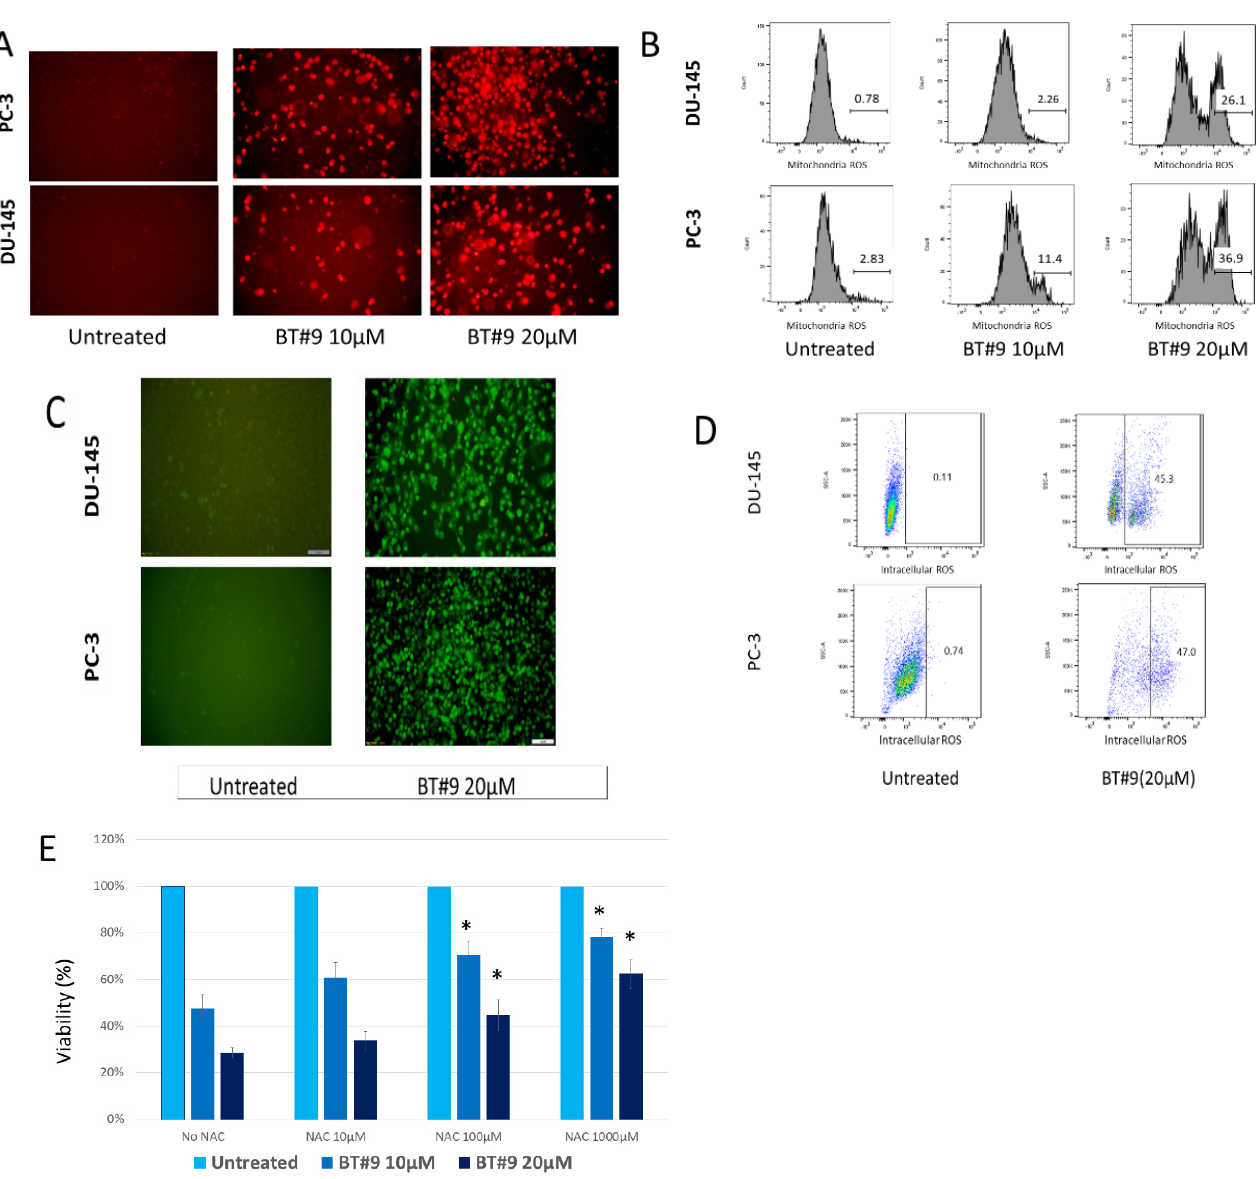
Figure 5. The accumulation of ROS in Prostate cancer cells after BT#9 treatment. ( A ) Intramitochondria ROS of PC-3 and DU-145 cells detected by MitoSOX Red superoxide indicator after 10 μ M or 20 μ M BT#9 treatment. ( B ) Representative flow cytometry histograms of MitoSOX Red fluorescence (530 nm lasor, PE channel) in PC-3 and DU-145 cells treated by 10 μ M and 20 μ MBT#9. Percentage of MitoSox Red positive cells was analyzed and quantified by FlowJo Software. ( C ) PC-3 and DU-145 cells were treated by BT#9 for 24 h, stained by 5 μ M CellROX Green Reagent, and Intracellular ROS was detected by fluorescence microcopy. ( D ) FCM measured the intracellular ROS level in both PC-3 and DU-145 cells, showing significant ROS accululation after BT#9 treatment (20 μ M). ( E ) NAC protected BT#9 induced cell death in a dose dependent way. Each experiment was repeated three times. * p < 0.05 (Unpaired two-tailed t test).